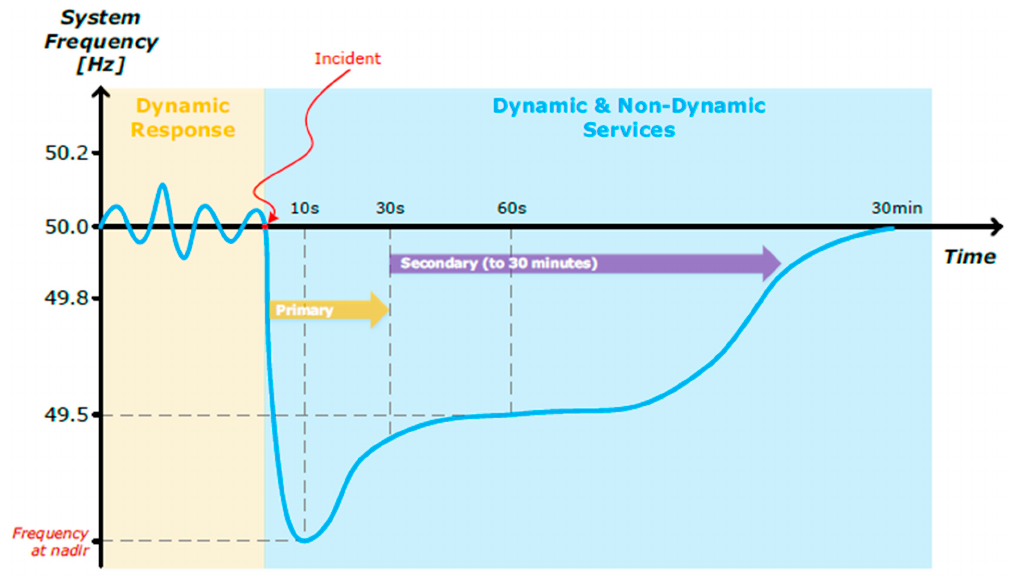
Figure 7. Illustration of reserve response to an unexpected event (From Torrealba Figure 7 . Illustration of reserve response to an unexpected event (From Torrealba [105]).